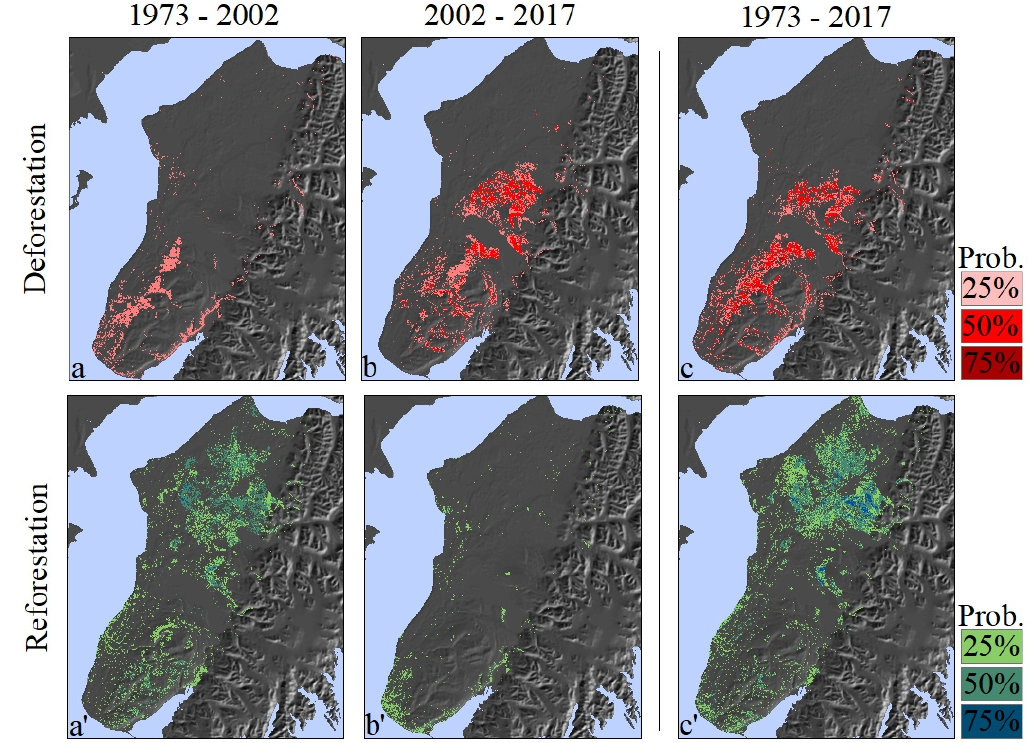
Figure 4. Patterns of deforestation and reforestation across the Kenai Peninsula Lowlands between 1973 and 2017. Color shades represent the proportion of decision tree votes (out of 500) in agreement with the depicted transition.